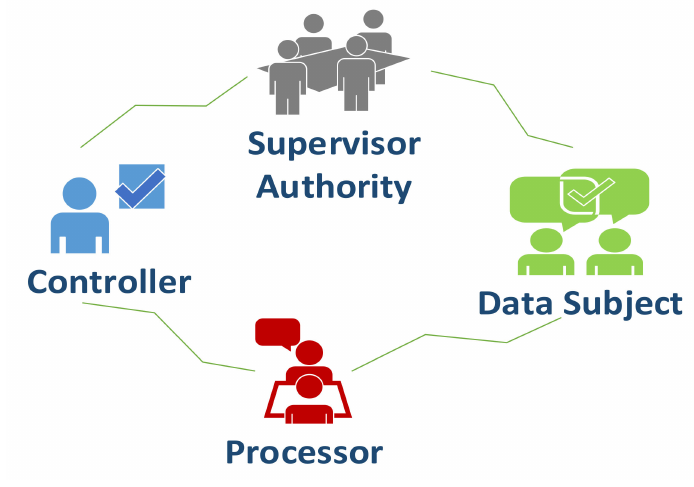
Figure 1. GDPR entities.